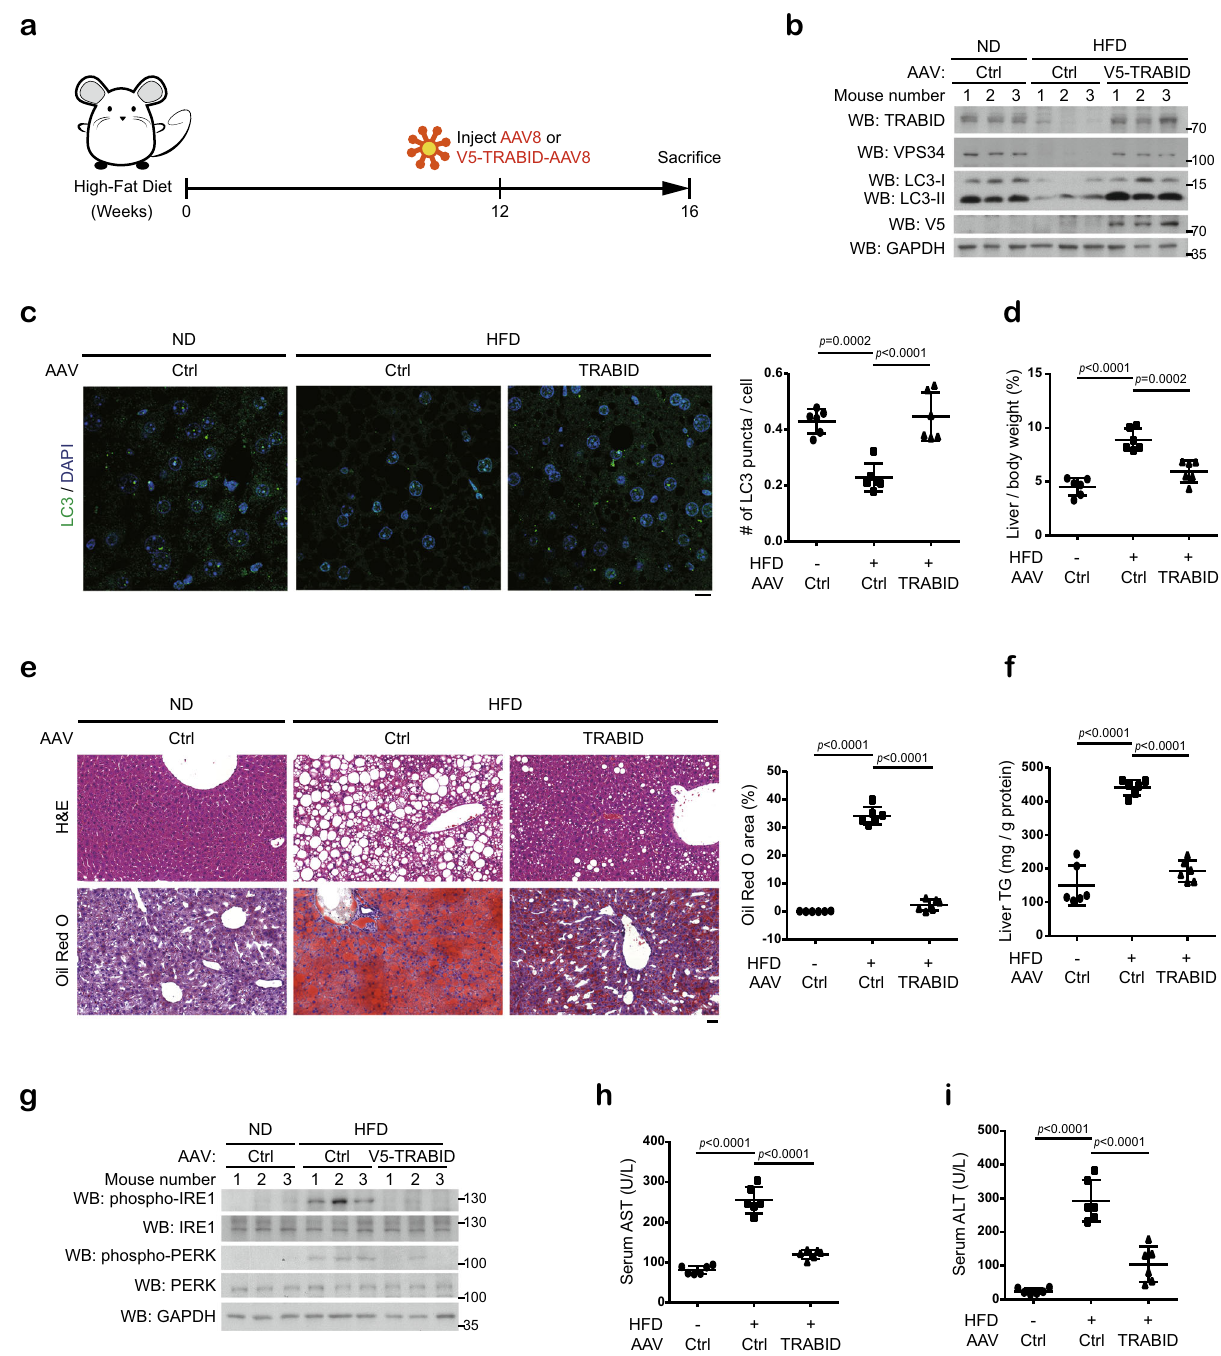
Fig. 7 TRABID-mediated VPS34 stabilization controls liver metabolism to alleviate NAFLD. a Schematic representation of the experimental design to evaluate the role of TRABID-mediated VPS34 regulation in NAFLD mouse model. b , g Western blot analysis of the expression levels of indicated proteins in liver tissues taken from mice on normal diet (ND) or high-fat diet (HFD). c Immuno fl uorescence staining of LC3 in liver sections from indicated mice. Representative images are on the left and quantitative data are on the right. Bar, 10 μ m. Data are mean ± SD ( n = 6, 40 – 70 cells/section were counted). P -values are determined by one-way ANOVA with Tukey ’ s post hoc test. d , f The percentage of liver per body weight ( d ) and liver triglyceride (TG) levels ( f ) in indicated mice. Data are mean ± SD from six mice. P -values are determined by one-way ANOVA with Tukey ’ s post hoc test. e H&E and Oil Red O staining of liver sections taken from indicated mice. Bar, 50 μ m. The percentages of area stained positive for Oil Red O were quanti fi ed and shown on the right. Data are mean ± SD from six mice. P -values are determined by one-way ANOVA with Tukey ’ s post hoc test. h , i AST and ALT assays in indicated mice. Data are mean ± SD from six mice. P -values are determined by one-way ANOVA with Tukey ’ s post hoc test. Source data are provided as a Source Data fi